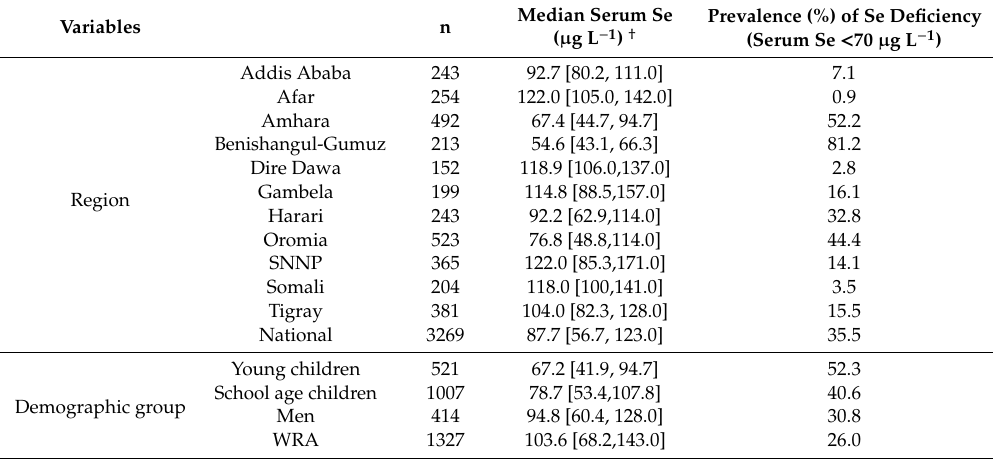
Table 2. Serum Se concentrations and prevalence of deficiency by region and demographic group in the Ethiopian National Micronutrient Survey, 2015.